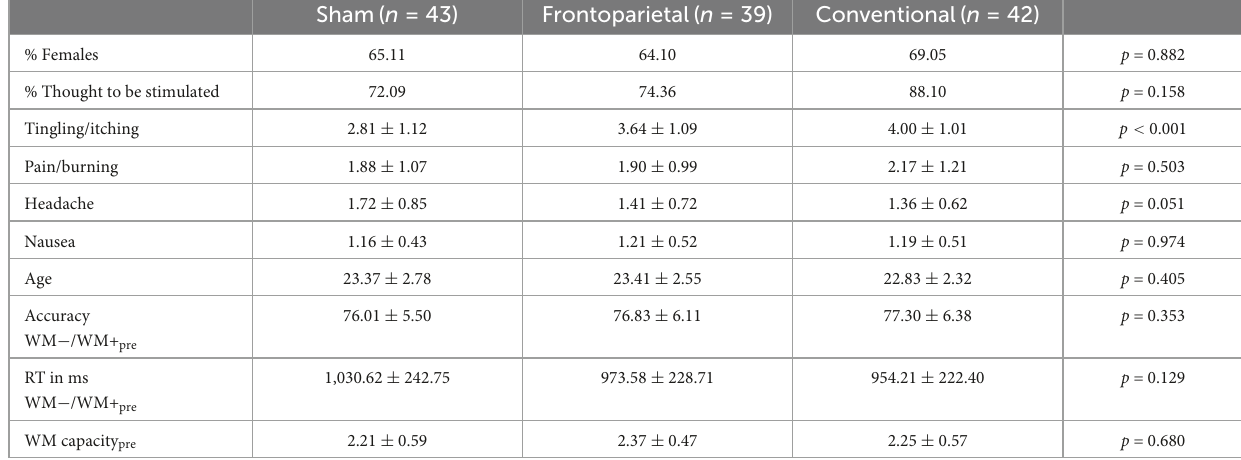
TABLE 1 Sample characteristics of the three stimulation groups.